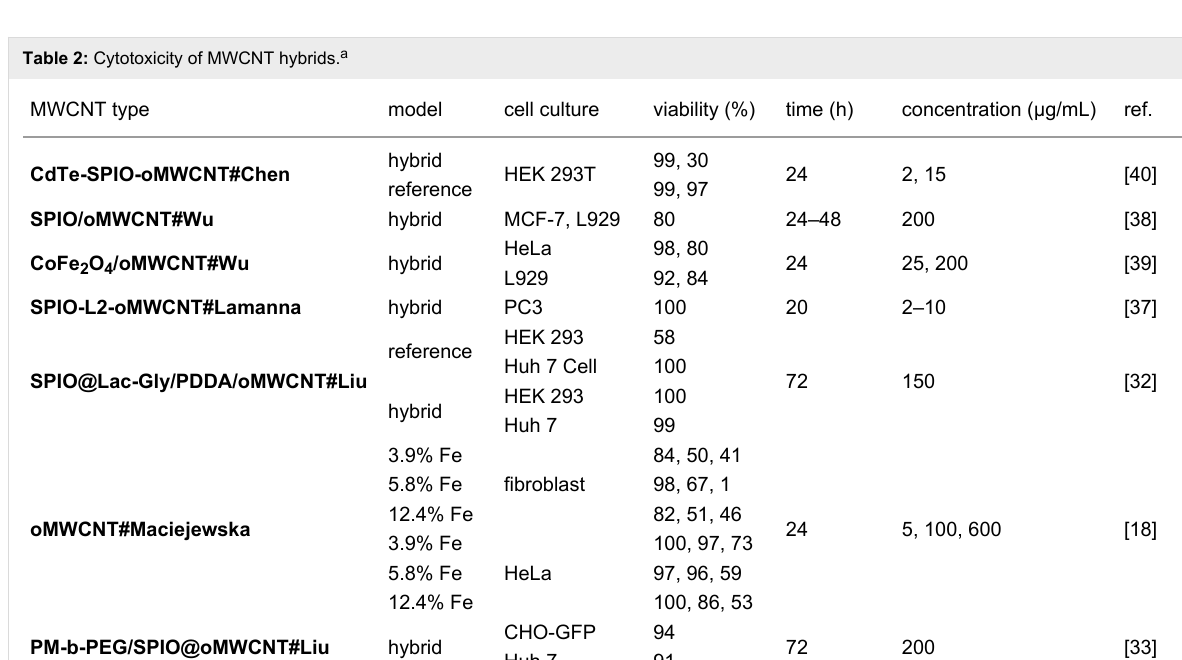
Table 2: Cytotoxicity of MWCNT hybrids. a